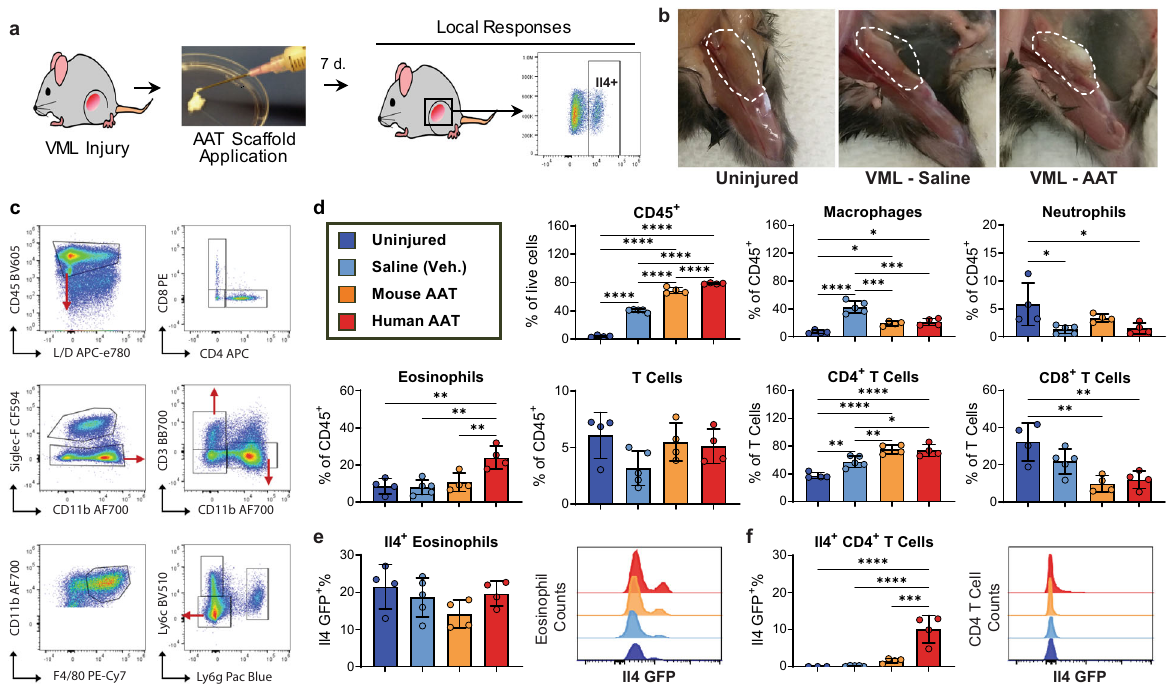
Fig. 3 AAT elicits pro-regenerative responses in a surgical wound model of irreversible volumetric muscle loss (VML) by recruiting Il4- expressing immune cells. a Mice with bilateral surgical resections in the quadriceps muscles were treated with direct application of an AAT scaffold or saline to the wound site immediately post-op. Animals were sacri fi ced after 1 week to evaluate local immune responses to the biomaterials by fl ow cytometry. b Gross images of healthy quadriceps muscle and VML wounds treated with either vehicle (saline) or an AAT scaffold 1-week post-injury. c Flow cytometry gating of immune populations in 4get mouse experiments (full gating in Supplementary Fig. 2). d Immune cell populations isolated from uninjured (healthy) control quadriceps muscles and muscle wounds treated with saline or an allogenic (mouse AAT, mAAT) or xenogeneic (human AAT, hAAT) ECM scaffold. e Il4 expression by percentage and median fl uorescence intensity (MFI) of eosinophils and f CD4 + T cells isolated from wounds in 4get mice. Signi fi cance between each pair of groups is shown ( p -values): * < 0.05, ** < 0.01, *** < 0.001, **** < 0.0001. Error bars represent ±1 standard